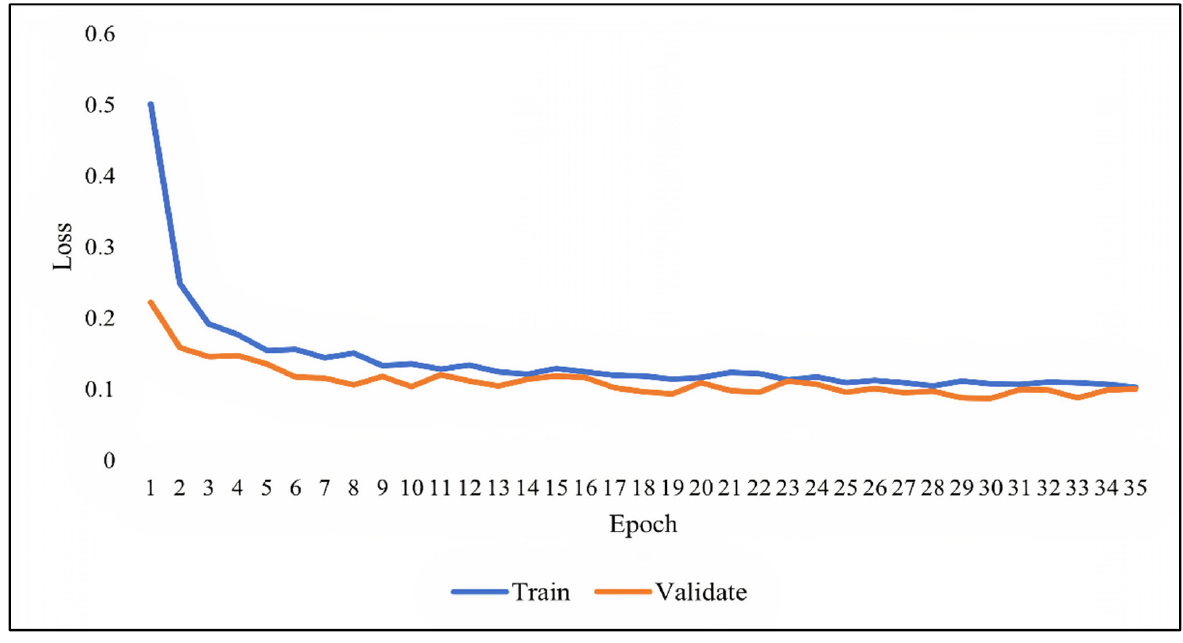
Figure 7. DNN learning curve during training.